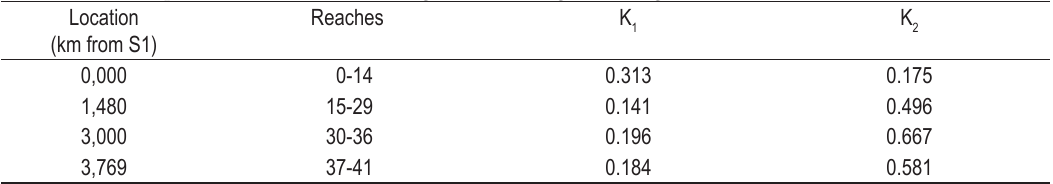
Table 3. Kinetics parameters at the monitoring Stations along the Fidalgo